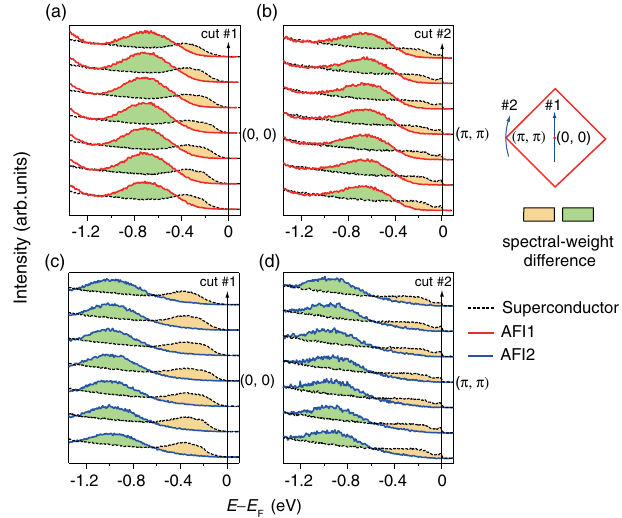
FIG. 3. Spectral-weight difference between the insulators and the superconductor. (a) and (b) compare EDCs of the AFI1 insulator and the superconductor along cuts #1 and #2 across the projected two-dimensional Brillouin-zone center and corner, respectively. (c) and (d) make the same comparison between AFI2 and the superconductor. Data for the insulators and super- conductor were taken at 180 and 11 K,